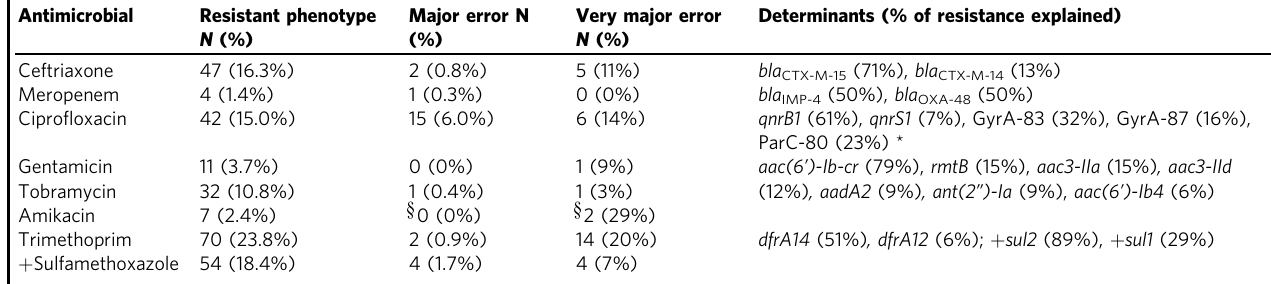
Table 3 Comparison of AMR phenotype vs genotype. Antimicrobial